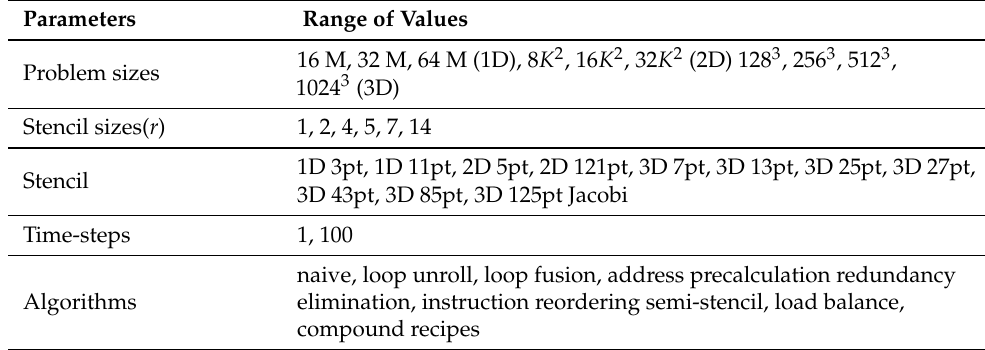
Table 1. List of parameters employed for the extended version of the classical stencil. Parameters